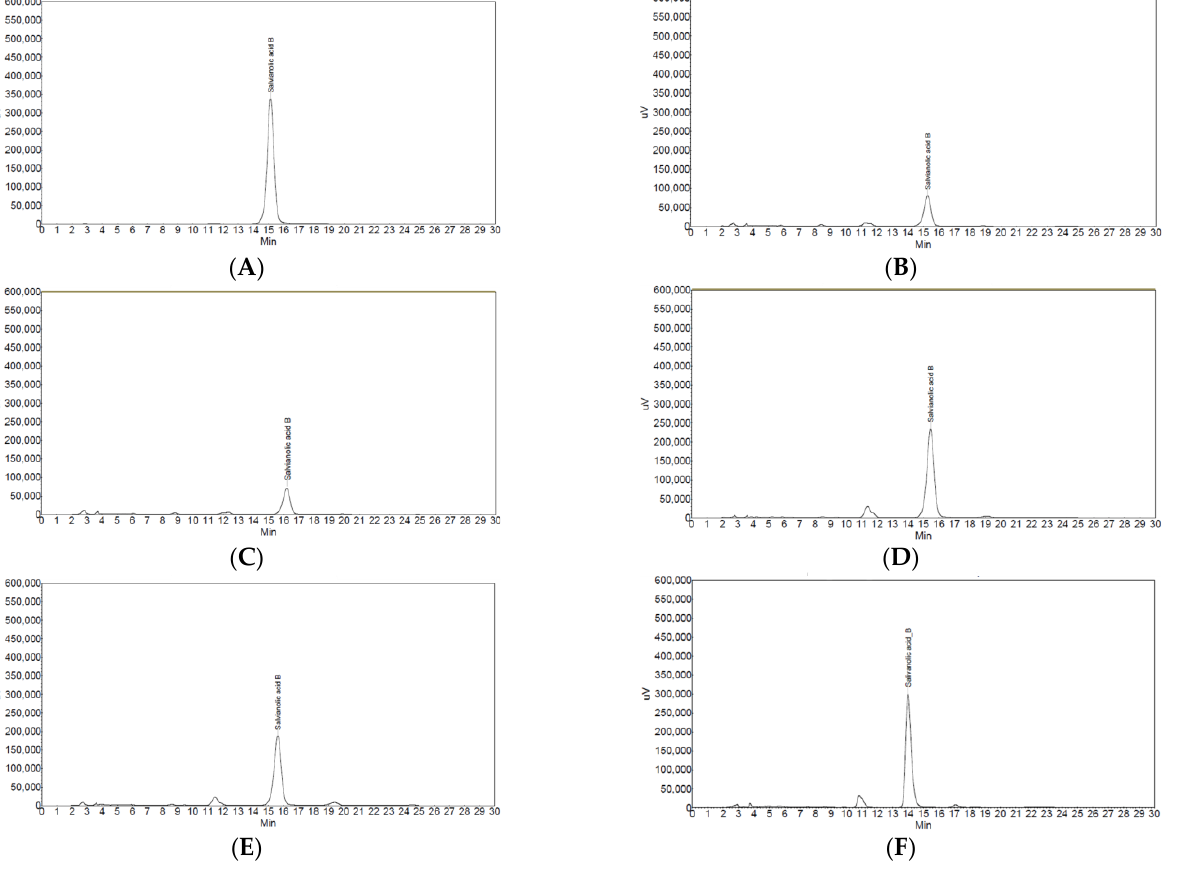
Table 3. Effects of experimental drug A60+B(C1) 30 mg/kg on infarct volume after pMCAO.